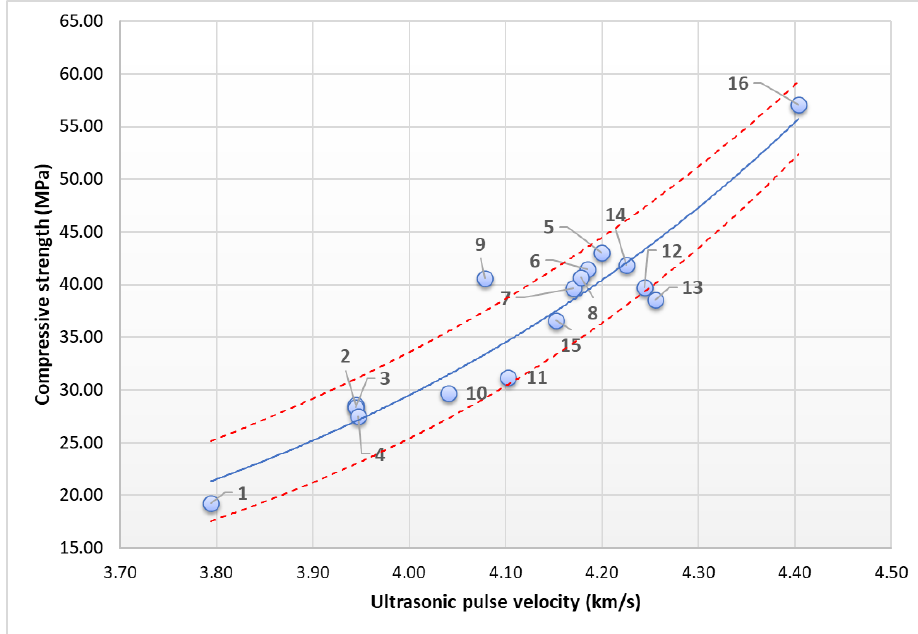
Figure 2. Presentation of the results of the compressive strength test concerning the calculated ultrasonic pulse velocity. The blue line represents the exponential trend of the values, and the red dashed lines represent the limits set with 95% confidence. Table 3. Results obtained for the statistical analysis of exponential